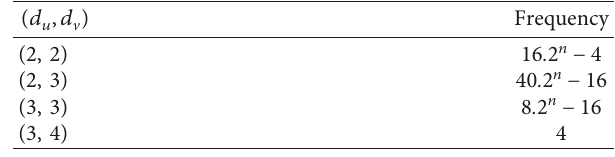
Figure 1: Prophyrin Dendrimer D Table 1: Degree-based edge partition of D each edge.